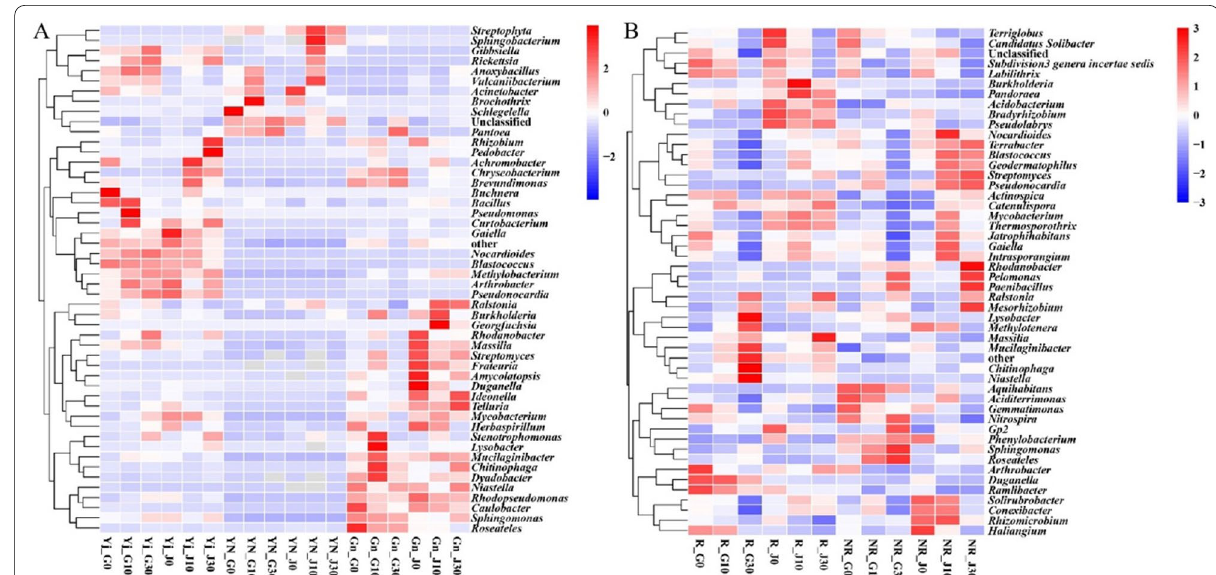
Fig. 4 Heatmap of the relative abundance of top 50 genera in plant ( A ) and soil ( B ) samples. Abbreviations: G0/J0, treatment with 0 mg/kg Cd in B. napus / B. juncea ; G10/J10, treatment with 10 mg/kg Cd in B. napus / B. juncea ; G30/J30, treatment with 30 mg/kg Cd in B. napus / B. juncea ; Yj phyllosphere samples, Yn endophytes samples from leaves, Gn endophytes samples from roots, R rhizosphere soil samples, NR bulk soil samples, the same